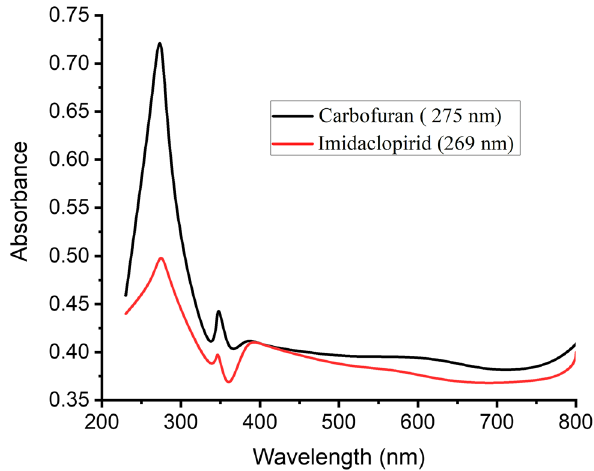
Figure 6. Wavelength of maximum absorbance for carbofuran and